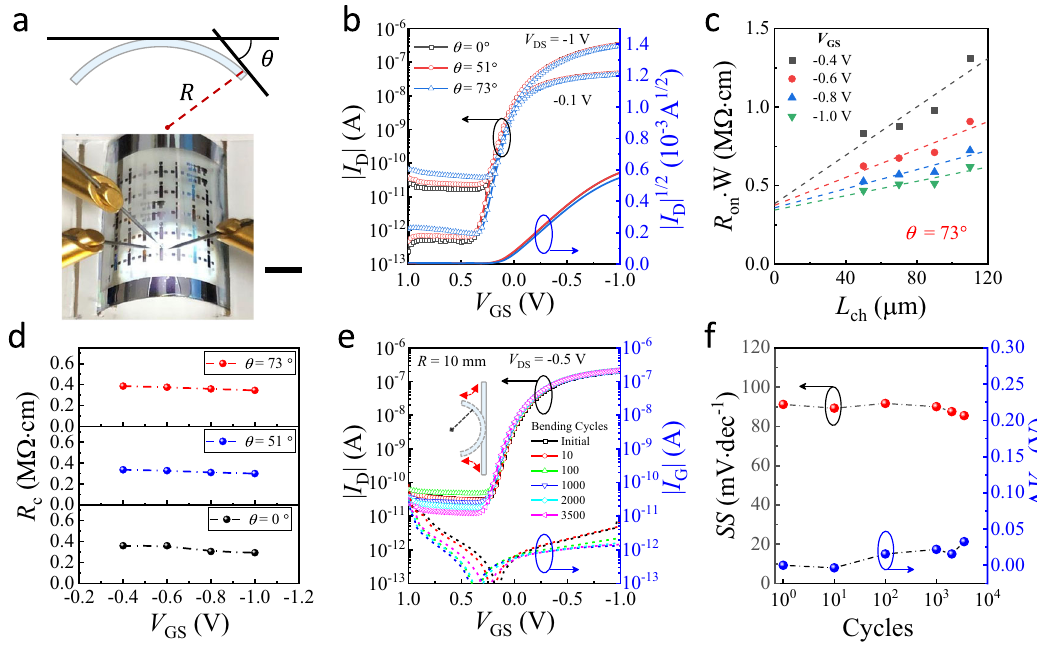
Fig. 3 Flexible OFET subjected to bending test. a Photoimage of a measured device under bending test with the schematic of bending angle ( θ ) and radius ( R ). The scale bar is 5 mm. b Transfer characteristics of OFETs (W/L = 1500 µm/90 µm) at different bending angles. c The measured channel-width-normalized total on-resistance ( R ON ·W) for fl exible OFETs of different channel lengths ( L ch ) bent at 73 ˚ . d The extracted contact resistance ( R C ) at different V GS for different bending angles based on the transmission-line method (TLM). e Transfer characteristics after different bending cycles (bending radius = 10 mm) and ( f ) the resulted change in subthreshold swing ( SS ) and threshold voltage ( Δ V th